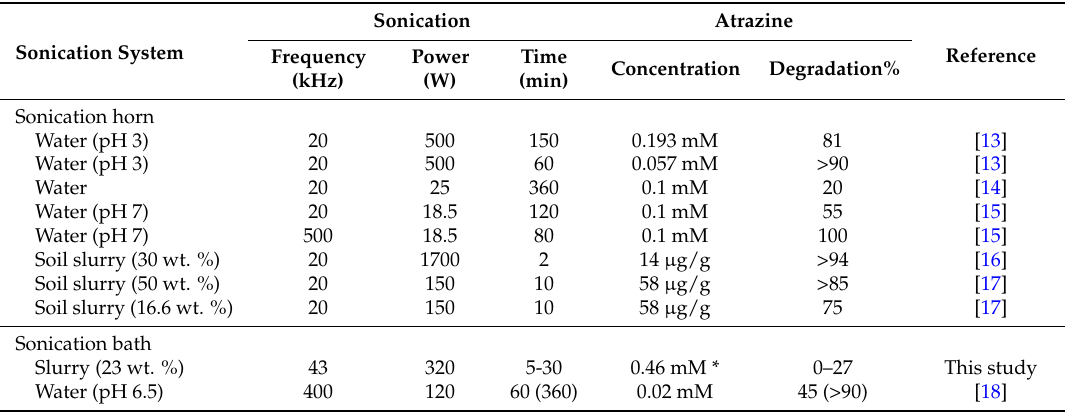
Table 2. The percentages of atrazine degraded by sonication. The initial concentrations in experiments, and sonication frequency, power and